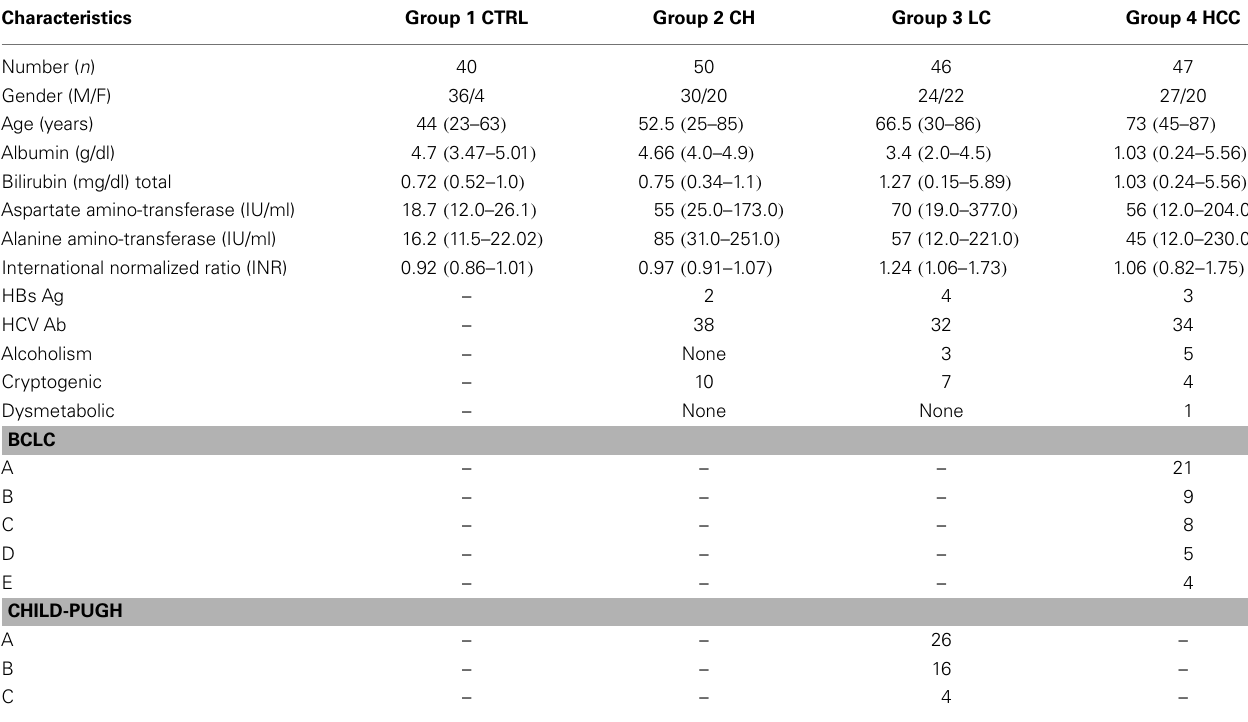
Table 2 | Clinical and pathological features of control patients without liver diseases (CTRL) and patients with chronic hepatitis (CH), liver cirrhosis (LC), and hepatocellular carcinoma (HCC); data are expressed as the median (range)